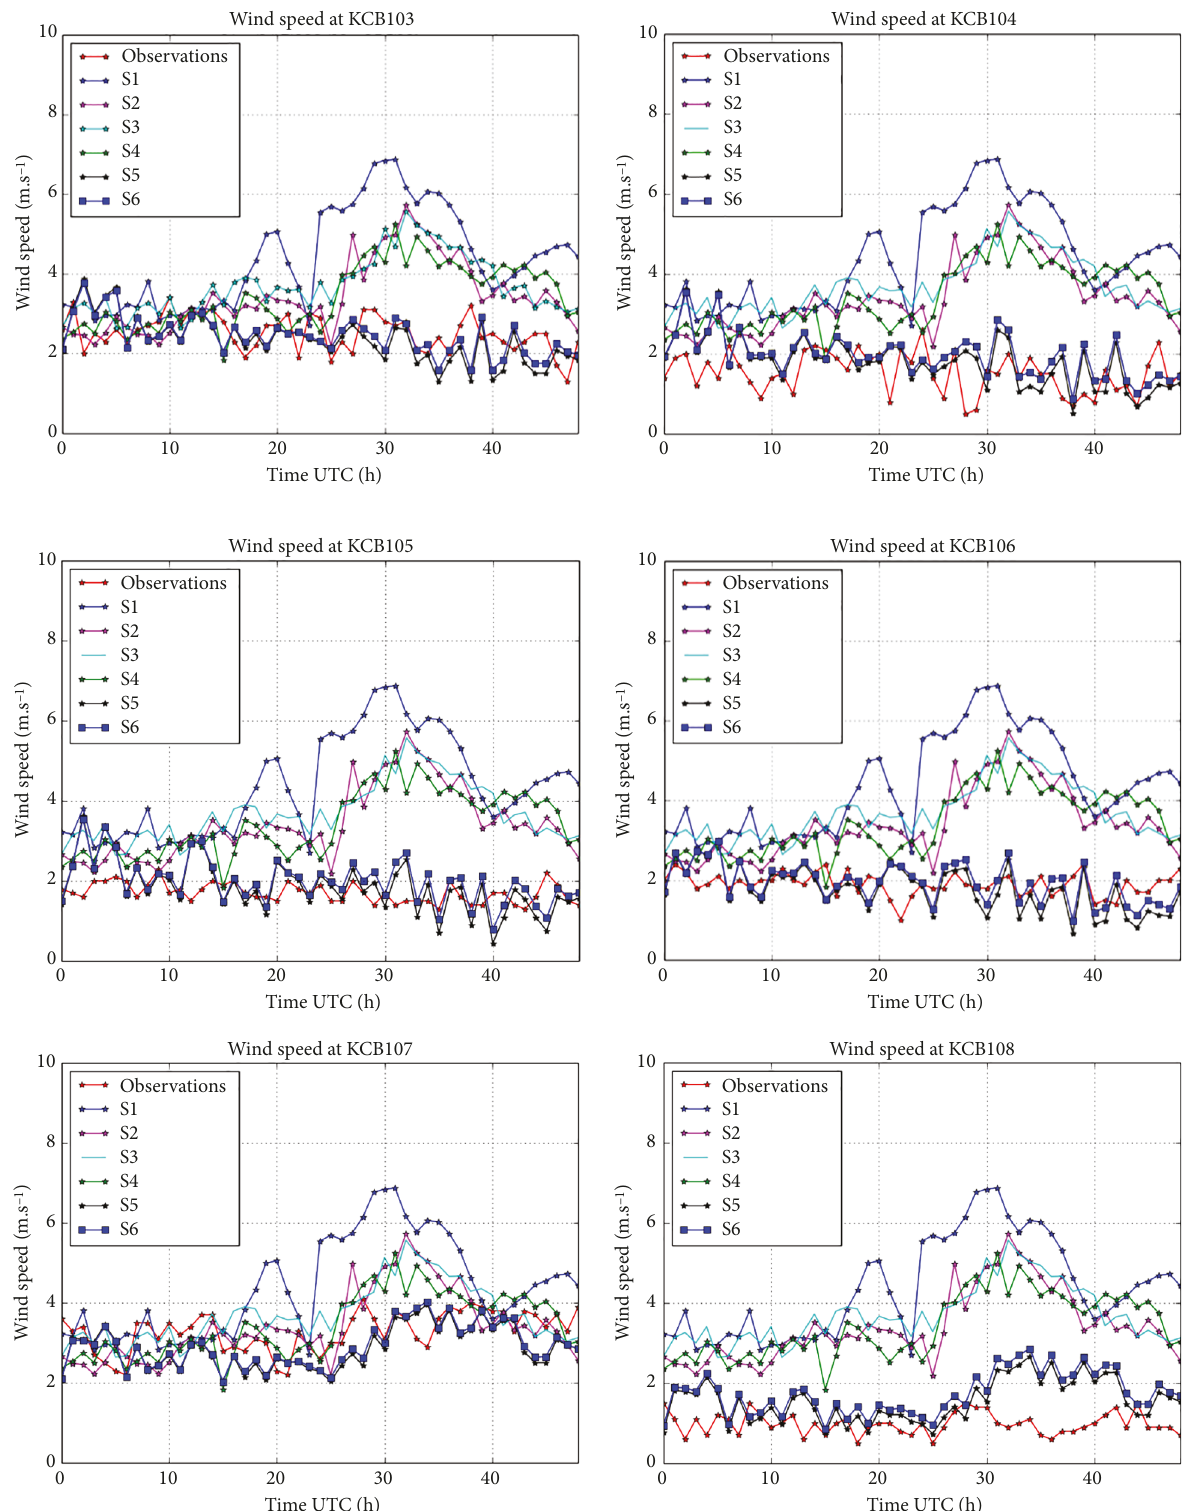
Figure 5: Temporal variations of simulated and observed wind speeds over the six Micronet stations: KCB103 (top left panel), KCB104 (top right panel), KCB105 (middle left panel), KCB106 (middle right panel), KCB107 (bottom left panel), and KCB108 (bottom right